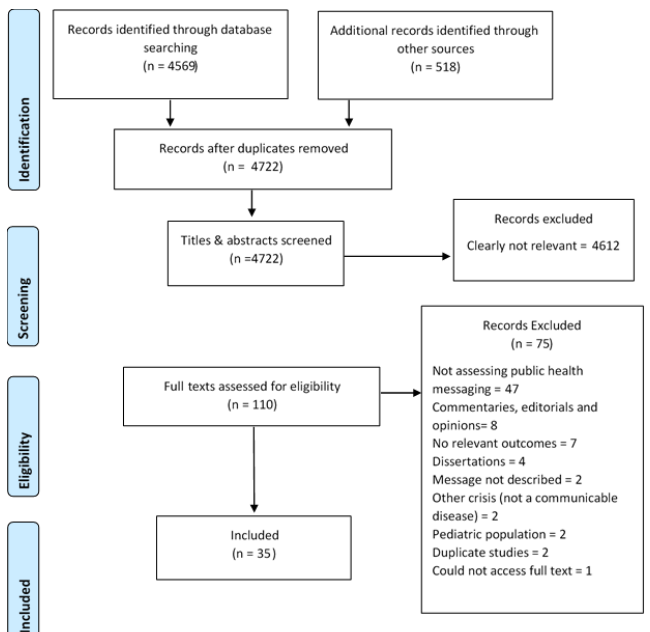
Figure 1. PRISMA Flow Chart.